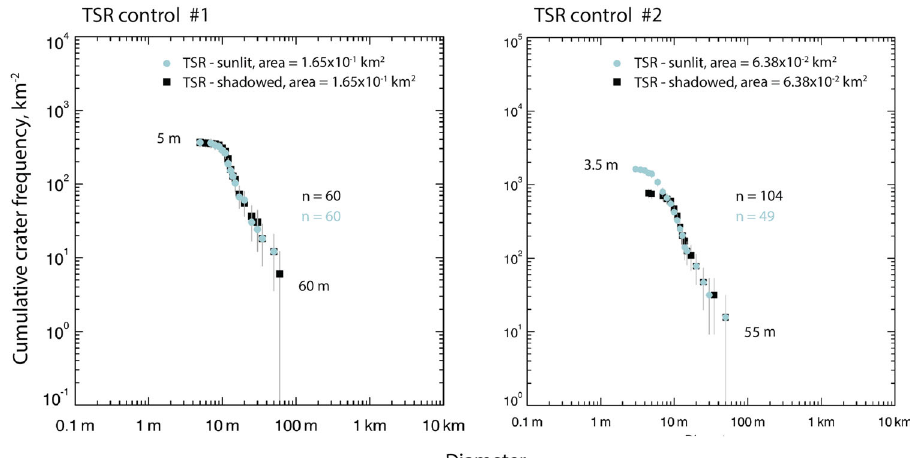
Fig. 6 Crater size-frequency distributions (CSFD) for a transiently shadowed region (TSR) control site (Latitude 89.82°S Longitude 44.01°W) next to A004 PSR 3. Left: Controlled comparison of two cumulative CSFD curves with 60 craters (log-log plot); controlled means that only craters are considered that are visible in sunlit (blue curve, M140007876RC) and shadowed conditions (black curve, M109598256L_HORUS). Both curves match well, indicating that crater diameter measurements performed in HORUS images appear to not introduce a signi fi cant observational bias. Right: Uncontrolled comparison of two cumulative CSFD curves (log-log plot); uncontrolled means that all visible craters within the area and images are considered (sunlit: blue curve, M140007876RC; shadowed: black curve, M109598256L_HORUS). The curves indicate that HORUS introduces an observational bias for crater diameters < ~8.5 m, i.e., some craters with diameters < ~8.5 m can be retrieved, but not all of them. Image M109598256L_HORUS is the same image used for the intra-PSR (permanently shadowed region) CSFD curve as discussed in the text (see Fig. S22). The error bars correspond to the statistical error of the ffiffiffiffi p cumulative numbers ( N ).